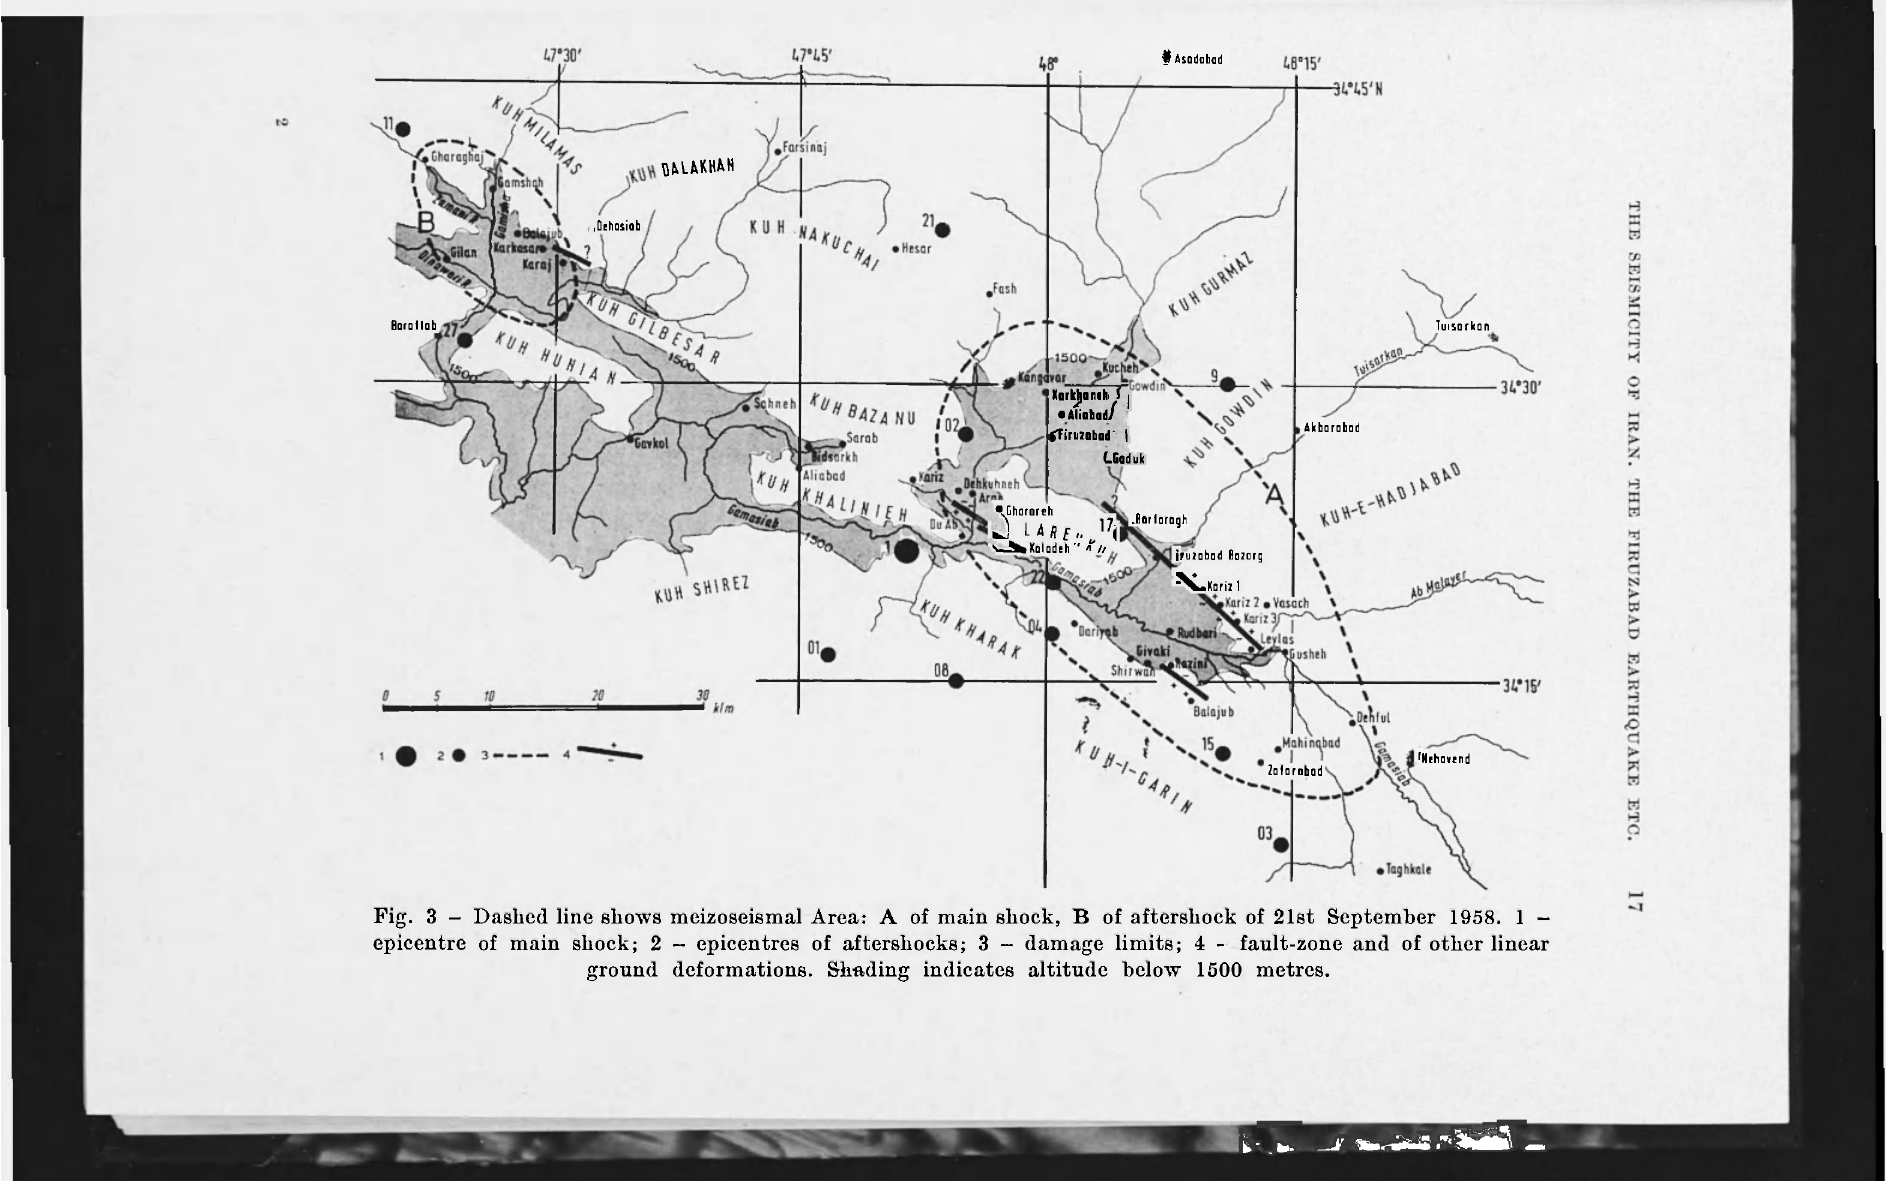
Fig. 3 - Dashed line shows meizoseismal Area: A of main shock, B of aftershock of 21st September 1958. 1 - epicentre of main shock; 2 - epicentres of aftershocks; 3 - damage limits; 4 — fault-zone and of other linear ground deformations. Shading indicates altitude below 1500